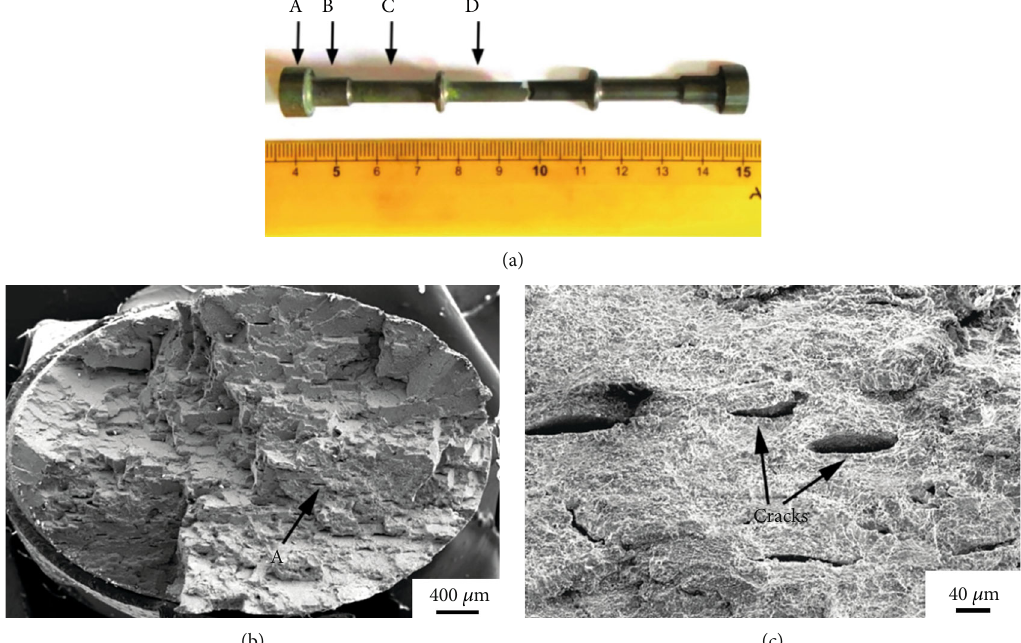
Figure 3: Sample photo and SEM images of the fracture morphology of the single crystal alloy IC6SX with [001] orientation after being crept for 56.3h and then up to fracture at 850 ° C/450 MPa. (a) Fracture specimen photo; (b) low multiple fracture morphology; (c) partial enlarged image of position A from (b).